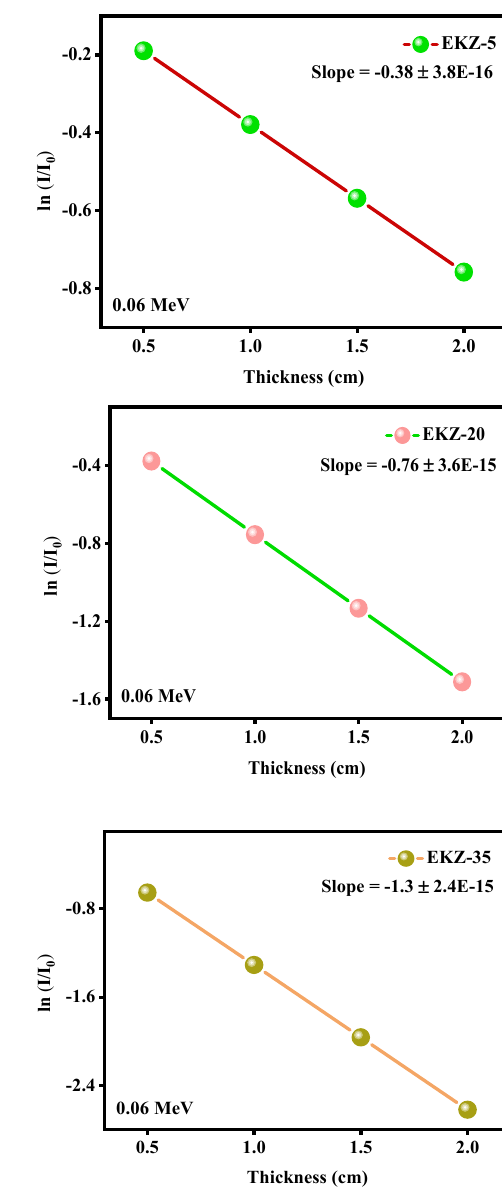
Figure 4. The ln (I/I 0 ) versus the thickness for all prepared samples at 0.060 MeV. The LAC, linear attenuation coefficient, and results for all the samples were calculated and graphed in Figure 5. For all six of the investigated samples, LAC and the incoming photon energy have an inverse relationship. More specifically, EKZ-5’s LAC values are equal to 0.379 cm − 1 at 0.060 MeV, 0.107 cm − 1 at 0.662 MeV, 0.081 cm − 1 at 1.173 MeV, and 0.076 cm − 1 at 1.333 MeV, while EKZ-25’s LAC is equal to 0.939, 0.135, 0.103, and 0.096 cm − 1 for the same respective energies. This relationship shows that the samples have a better attenuation ability against lower energy photons. The figure also demonstrates that additional kaolin clay and ZnO-nanoparticles lead to an enhancement in the LAC values of the samples. At 0.662 MeV, the LAC values are equal to 0.1006 cm − 1 , 0.1069 cm − 1 ,